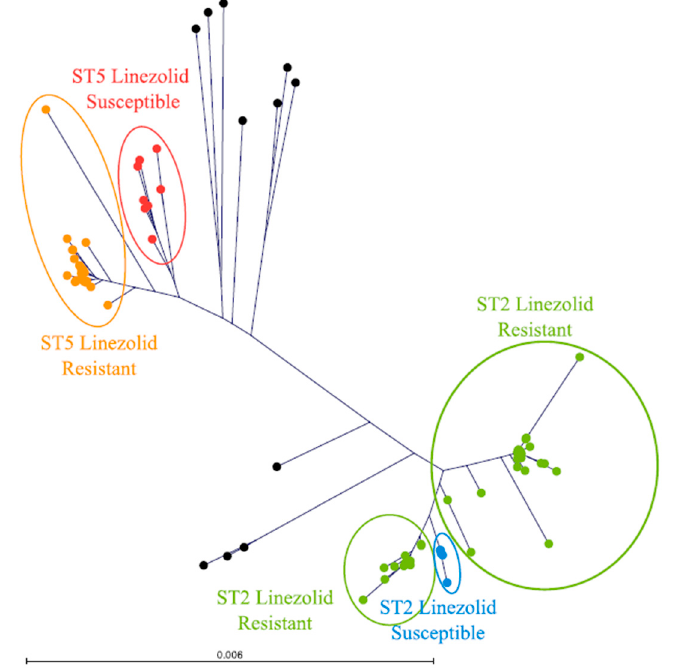
Figure 1. Phylogenetic tree of linezolid-resistant S. epidermidis (LRSE) and linezolid-susceptible S. epidermidis (LSSE) isolates. Coloring of the tree corresponds to manual partitions for the two dominant sequence types (ST) ST2 and ST5 as well as associated linezolid resistance. Leaves colored in black correspond to ST2, ST5, ST23, ST32, ST87, ST190, and STnovel.